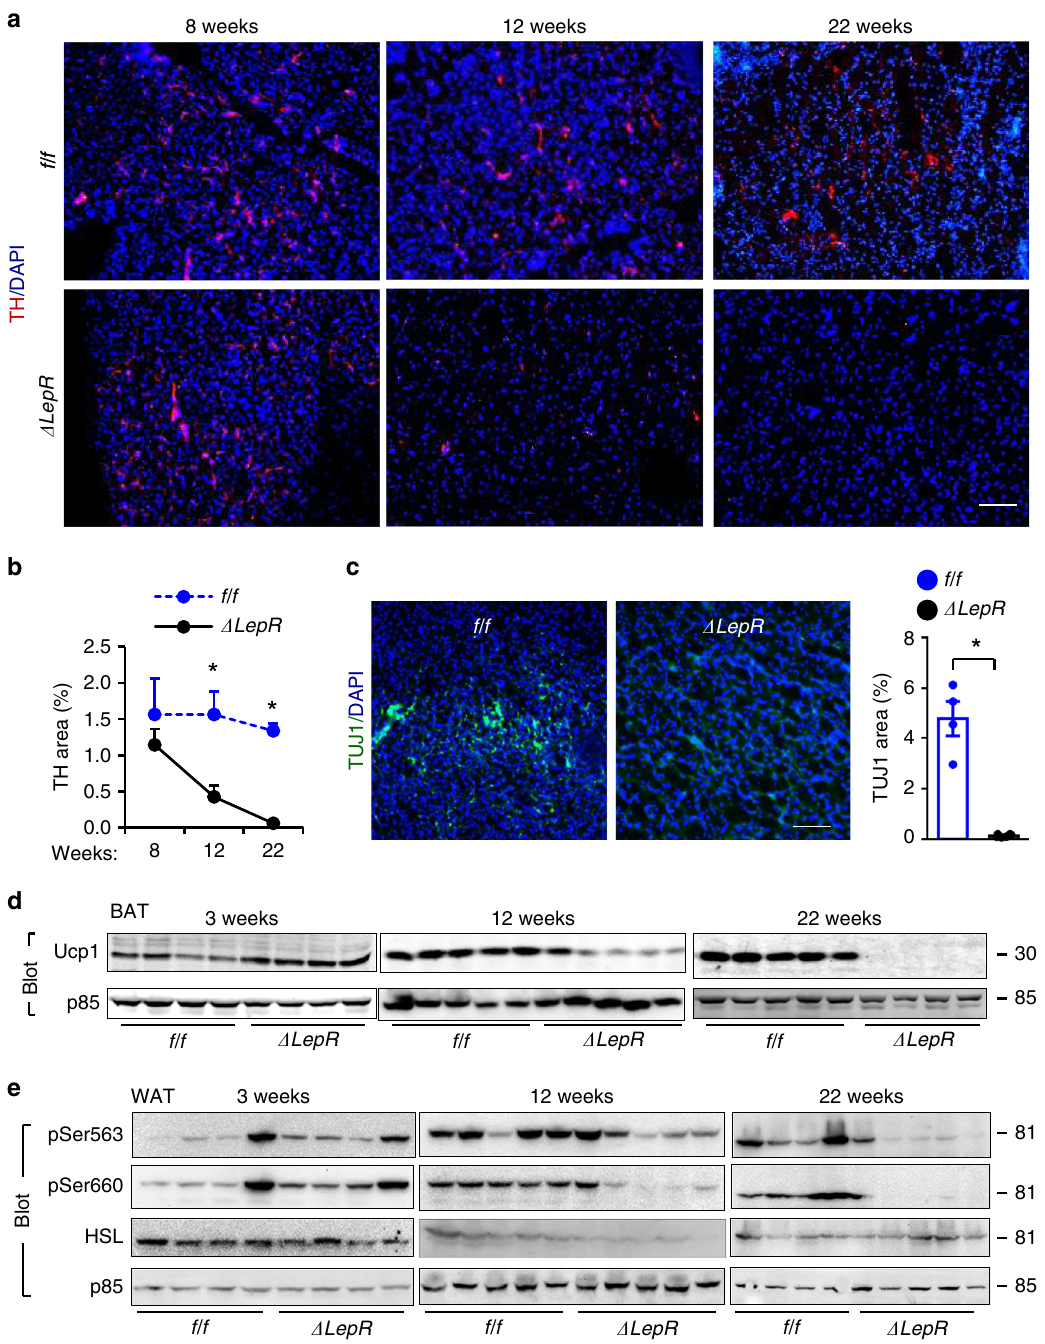
Fig. 7 Sh2b1 in LepR neurons supports the maintenance of adipose SNS. a , b BAT sections were prepared from male mice at 8, 12, and 22 weeks of age and stained with anti-tyrosine hydroxylase (TH) antibodies. a Representative images ( n = 3 mice per group). b TH areas were quanti fi ed and normalized to total areas ( n = 3 mice per group). c BAT sections were prepared at 22 weeks of age and stained with anti-TUJ1 antibody. TUJ1 areas were normalized to total areas. Sh2b1 f/f : n = 4, Sh2b1 Δ LepR : n = 6. d , e BAT ( d ) and epididymal WAT ( e ) extracts were prepared from male mice at 3, 12, and 22 weeks of age and immunoblotted with the indicated antibodies. Each lane represents an individual mouse. Data are presented as mean ± SEM. * p < 0.05, two-tailed unpaired Student ’ s t -test. Source data are provided as a Source Data fi